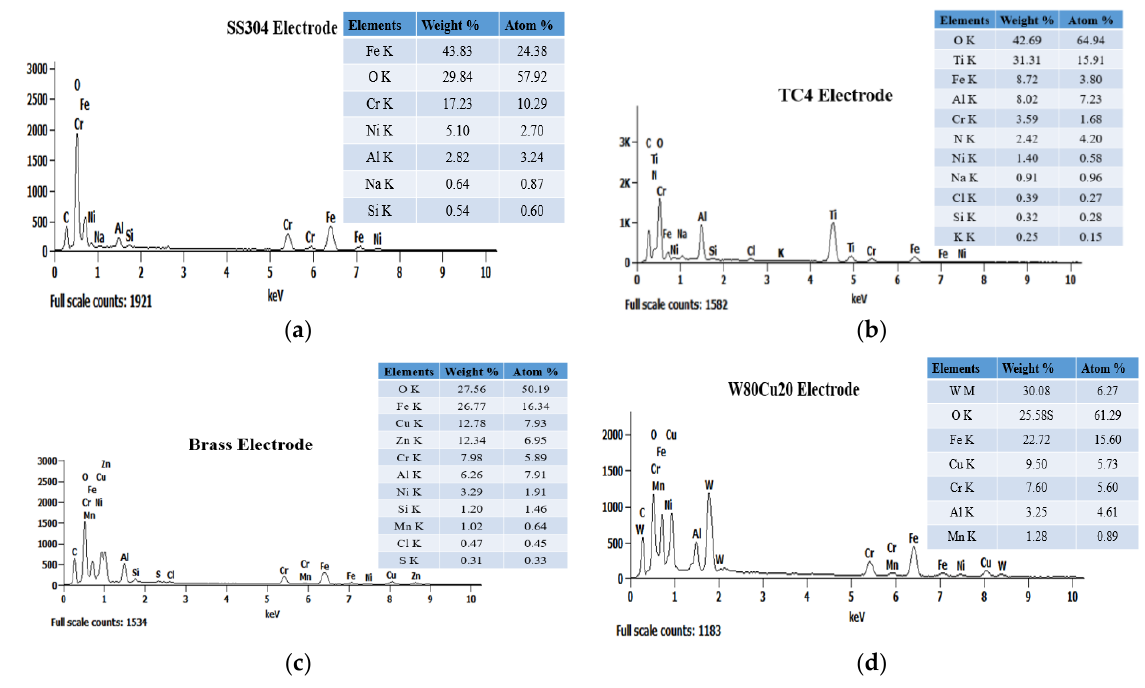
Figure 9. EDX spectrum analysis of four electrodes after ECDM: ( a ) SS304; ( b ) TC4; ( c ) brass; ( d ) W80Cu20.